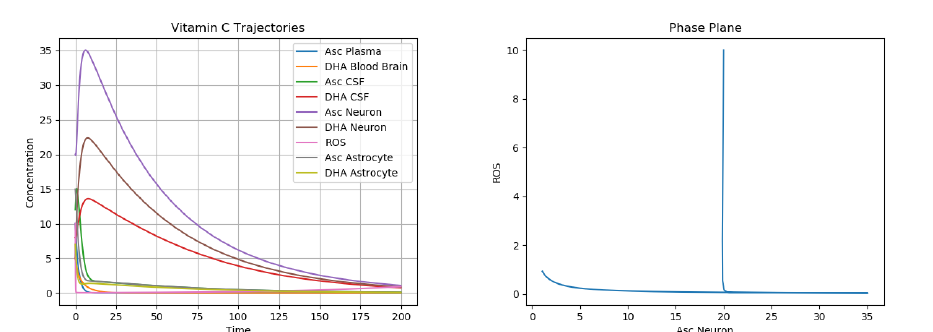
Figure 2. Dynamics of AA, DHA, and ROS in a Control